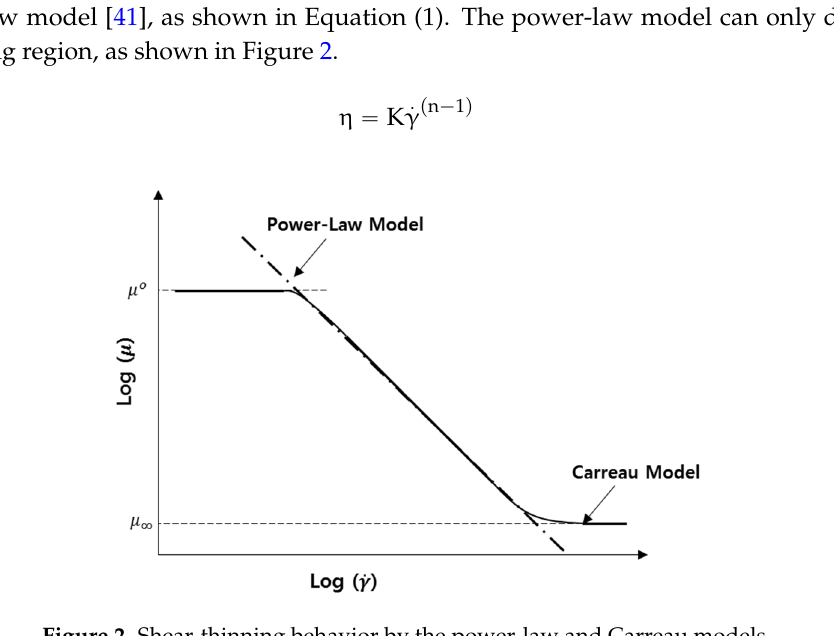
Figure 2. Shear-thinning behavior by the power-law and Carreau Figure 2. Shear ‐ thinning behavior by the power ‐ law and Carreau models.